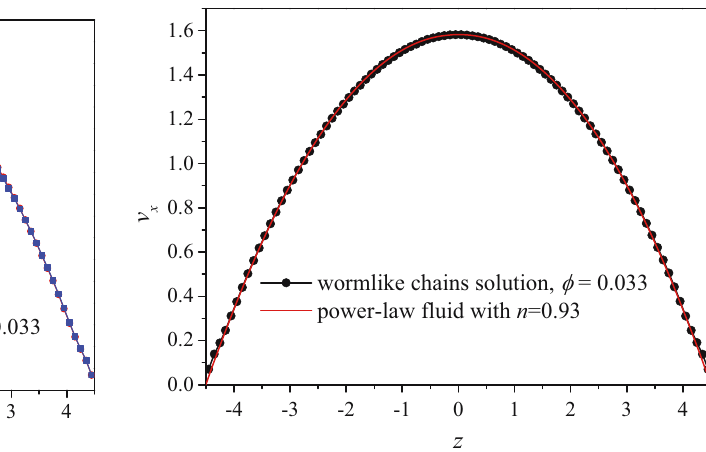
Figure 9: The velocity pro fi le of the wormlike chain solution with ϕ = 0.033 compared to that of the power - law fl uid with n =